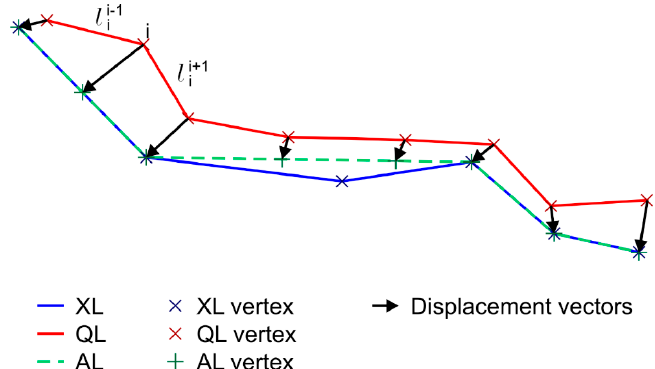
Figure 4. The Vertex Influence Method by Vertexes (VIM-V) approach proposed in this study.